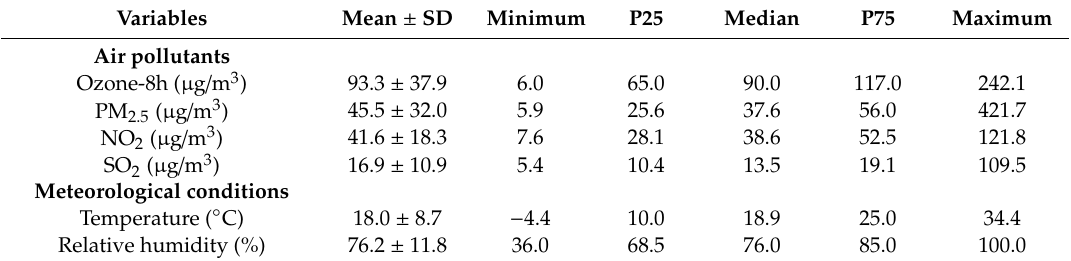
Table 1. Daily air pollutant concentrations and meteorological conditions in Ningbo, China, from 2013 to